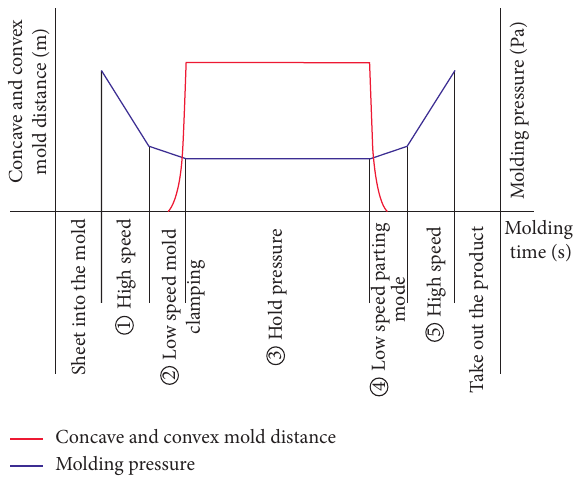
Figure 3: Speed variation graph during the mold clamping.